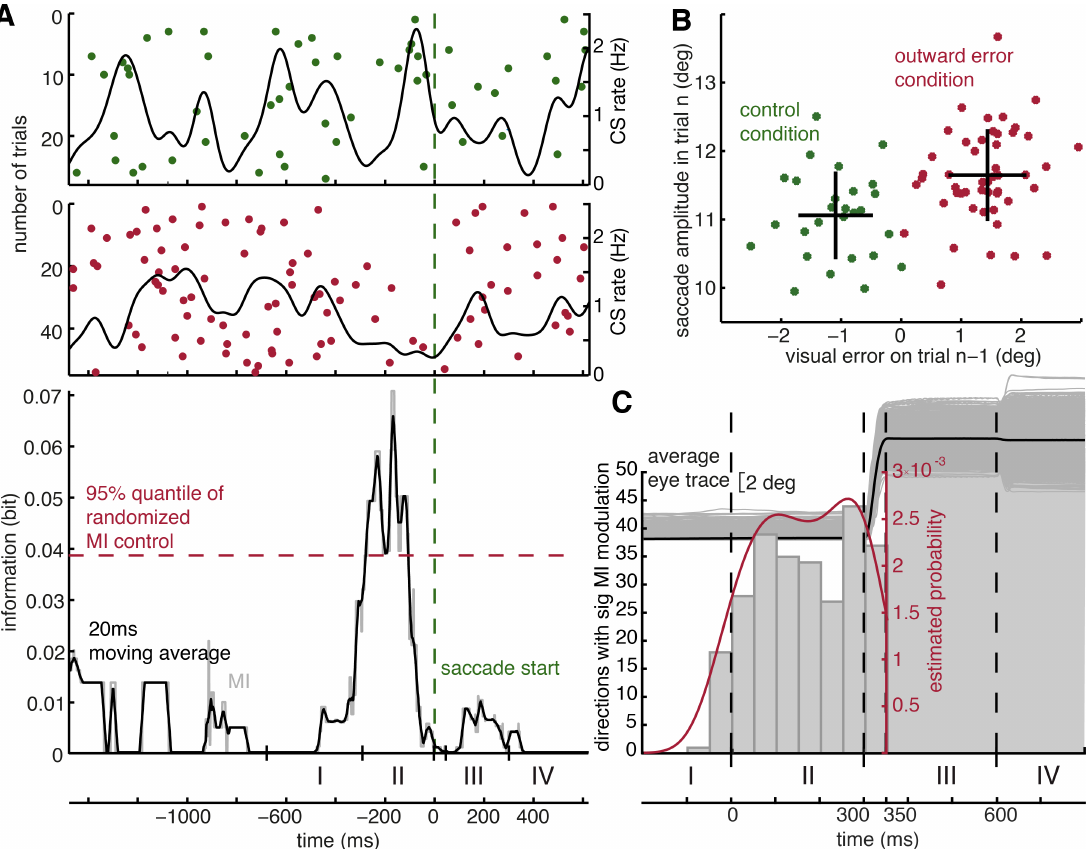
Fig 3. CS modulation is impacted by information from the past trial. A Exemplary CS unit represented by raster plot and the respective CS density curve (top) and plot of MI as function of time (bottom). The colors distinguish the error type in trial n − 1, preceding the trials shown in the raster plot (green: control, red: outward error); same direction for primary saccades. All trials were aligned to the onset of the primary saccade, represented by the vertical dashed green line. Note that the biggest difference between the two conditions lies right before the primary saccade, indicating that information about the condition in trial n − 1 is available before the primary saccade on trial n is executed. Note further that the inequality in the number of trials per condition is taken into account by the MI analysis. Further note that the designated intervals at the bottom are approximate and for visual illustration only, as the different events jitter from trial to trial due to the monkeys’ varying response times. B Plot of saccade amplitude in trial n as function of visual error in the preceding trial n − 1, demonstrating a clear impact of random errors on amplitude in one direction. The plot is based on the same set of trials from one direction of an exemplary session for which the CS discharge is shown in Fig 3A. Green dots correspond to trials with no target jump (control condition) in trial n − 1, and red dots indicate trials with an outward error condition (outward target jump) in trial n − 1. Black crosses indicate mean and standard deviation of each cluster. The mean saccade amplitudes are significantly different for the two sets (ANOVA, p < 0.01). C Distribution of times of significant trial-by-trial MI modulation of CS units. The time points of maximal significant modulation were mapped into the frame of a standardized saccade trial as in Fig 2C. The resulting distribution analogous to Fig 2C demonstrates that given a CS unit exhibits a change in CS activity in trial n due to a certain error condition in trial n − 1, it is most likely to observe this modulation before the primary saccade in trial n . The grey shaded area marks those intervals of trial n in which an influence of error information from trial n − 1 can no longer be disentangled from the error information associated with the performance in trial n . Underlying data available from the Dryad Digital Repository: https://doi.org/10.5061/dryad.p88b8v8. CS, complex spikes; MI, mutual